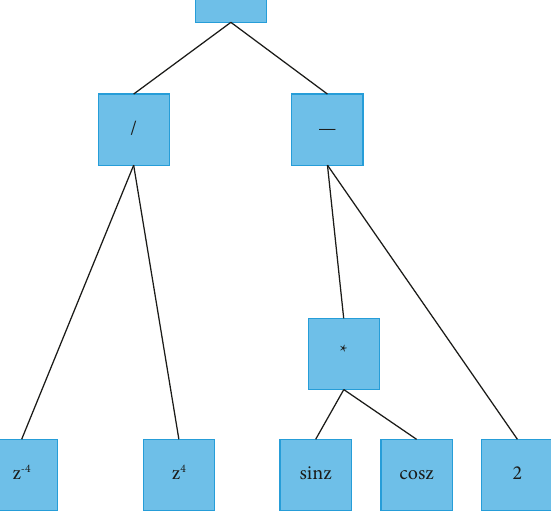
Figure 5: Tree B z − 4 / z 4 − ctgz − 1.